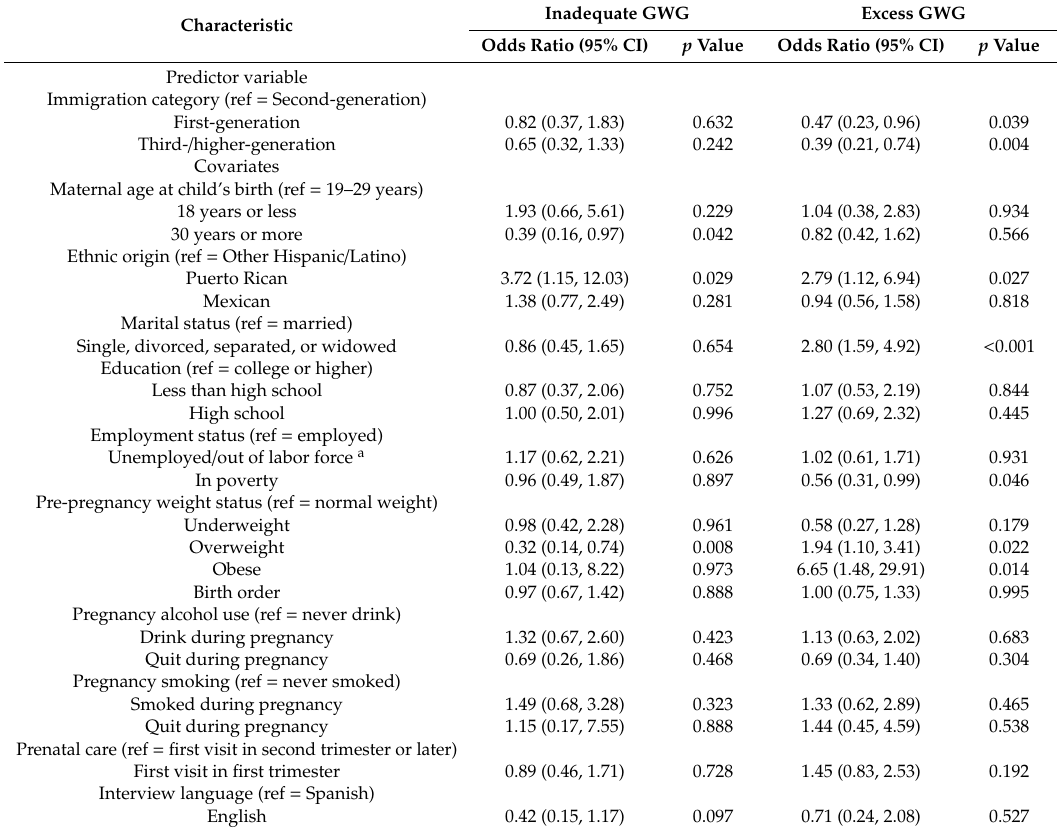
Table 2. Multivariate logistic regression of immigration generations status predicting the risk of inadequate and excess gestational weight gain (GWG; unweighted count =